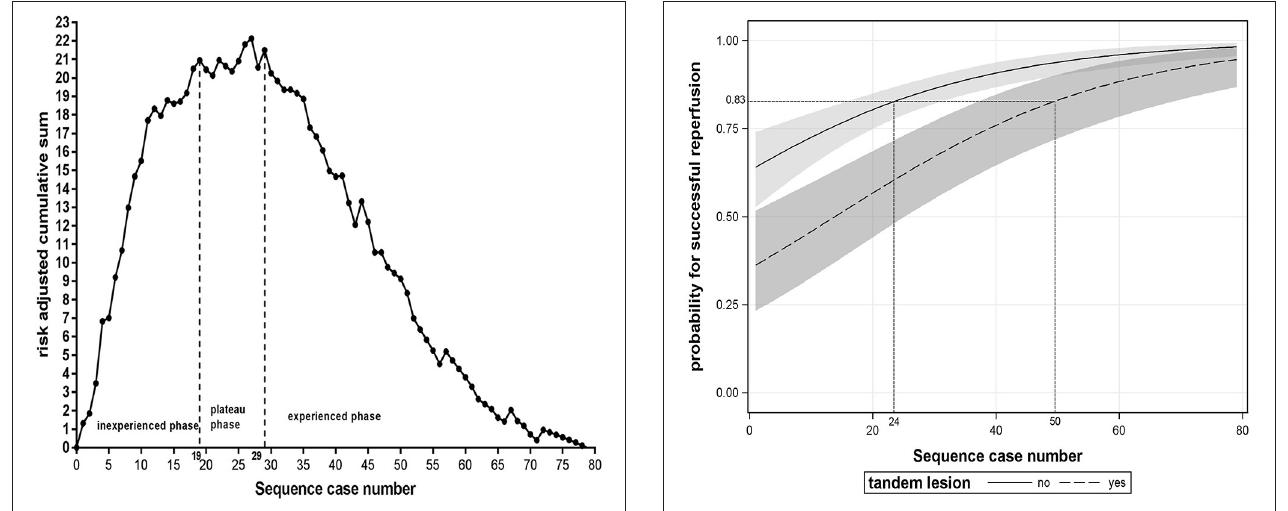
FIGURE 4 | The association between procedural experience and successful reperfusion stratified by tandem lesion. The black line and dotted line with shaded bands represent the adjusted predicted curves with 95% confidence